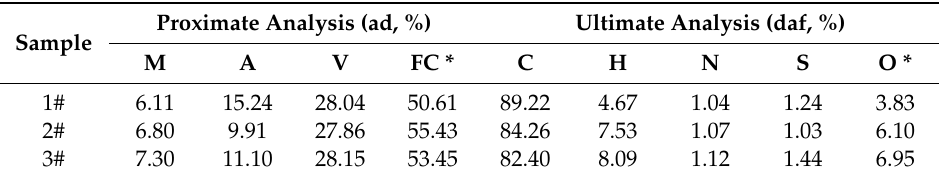
Table 1. Proximate and ultimate analysis of the